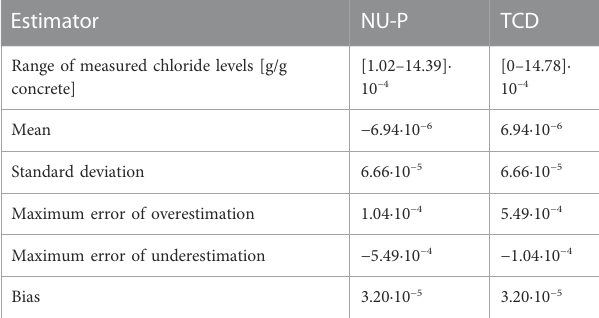
TABLE 3 Statistical estimators of measurement errors: case of series 2.